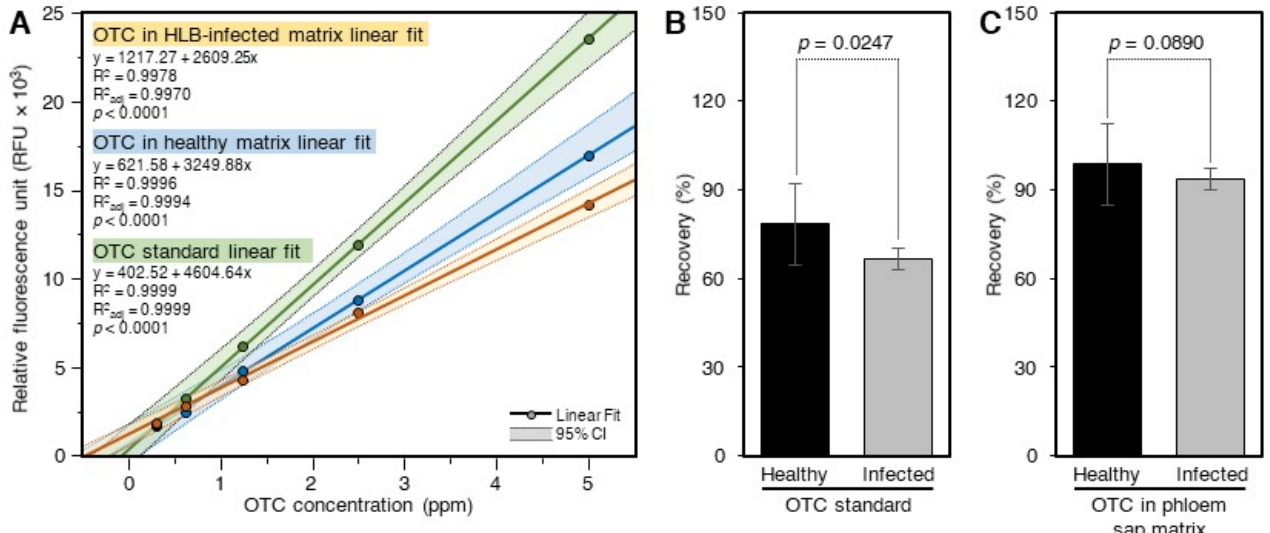
Figure 3. Recovery of OTC from spiked citrus phloem sap. ( A ) Standard curves of OTC in 60% methanol and citrus phloem sap obtained from healthy and ‘ Ca. L. asiaticus’-infected plants. The standard curves were prepared in the phloem sap matrix by spiking phloem sap extracts with OTC and then passing through the SPE cartridge. ( B ) Recovery of OTC from spiked ‘ Ca. L. asiaticus’-infected and healthy phloem sap as calculated using the pure standard. ( C ) Recovery of OTC from spiked ‘ Ca. L. asiaticus’-infected and healthy phloem sap as calculated using the standards prepared in the phloem sap extracts of healthy and ‘ Ca. L. asiaticus’-infected plants and cleaned using SPE. Data are the means ± SD of five replicates ( n = 5). Values with p -values < 0.05 are significantly different using a two-tailed student t -test.